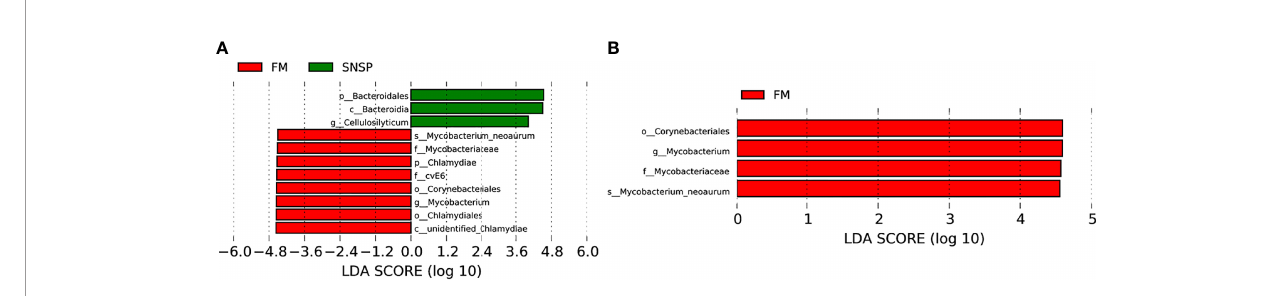
FIGURE 4 | LEfSe analysis of intestine microbial compositions among different groups. (FM, SNSP, INSP and NSP). Signi fi cant differences (LDA score ≥ 2, P < 0.05) between FM and SNSP (A) , FM and NSP, (B) . There was no signi fi cant difference between the other groups ( P